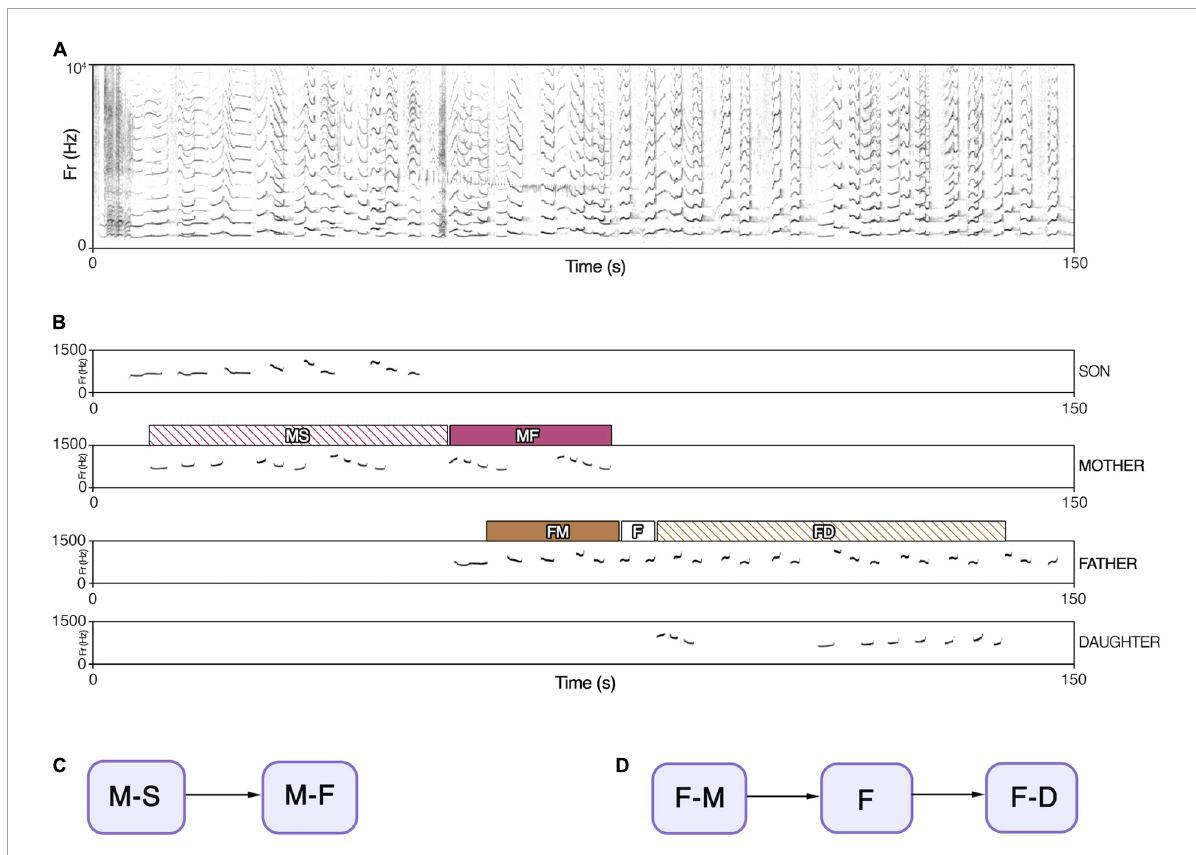
FIGURE1 (A) A spectrogram of an indri chorus. (B) Individual contributions extracted from panel (A) ; the parents’ type of co-singing is highlighted by different color bands. MS, mother duetting with son; MF, mother duetting with father; FM, father duetting with mother; F, fathers’ solo units, FD, father duetting with daughter. (C) Flow diagram representing mother’s co-singing transitions, extracted from panel (B) . (D) Flow diagram representing fathers’ co-singing transition, extracted from panel (B)